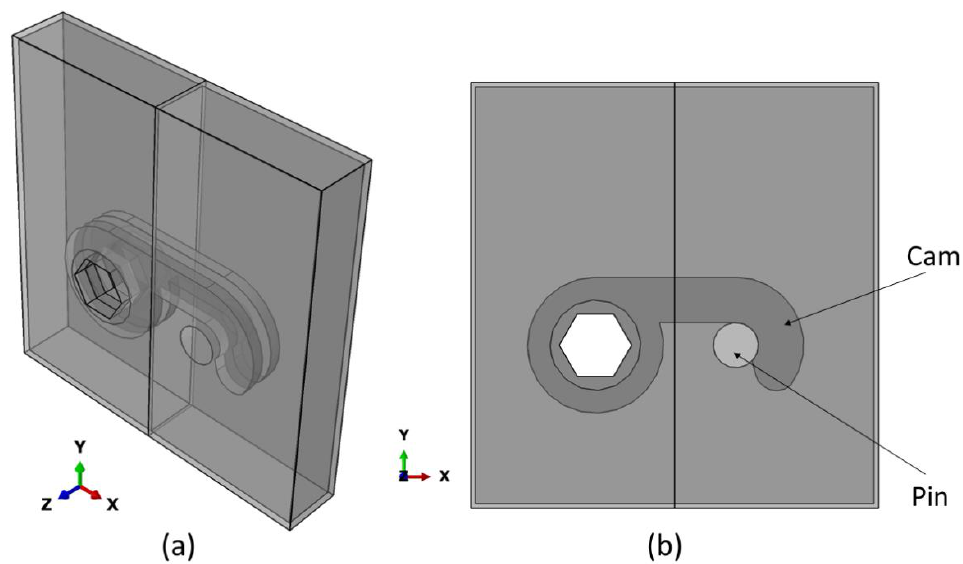
Figure 3. Three-dimensional transparent model of ( a ) the camlock system and ( b ) the transparent front view of the camlock system.